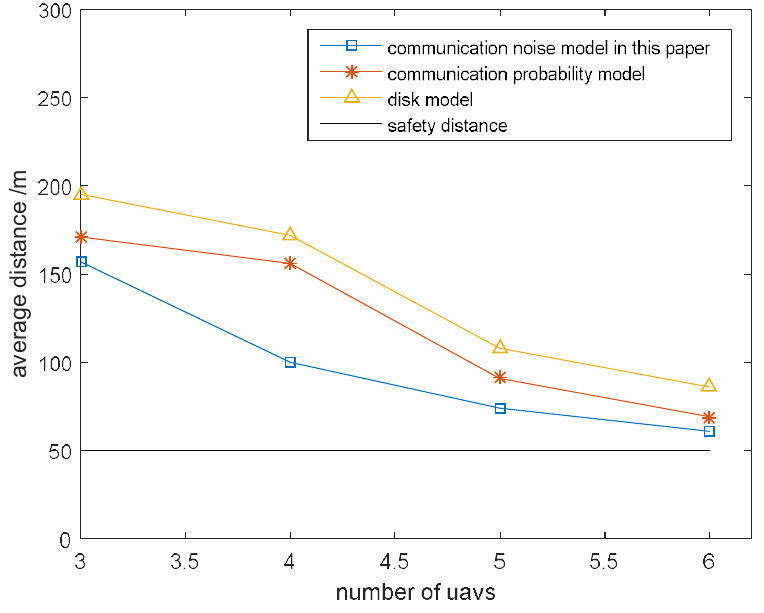
Figure 11. Estimate error with different methods (number of UAVs was 8).